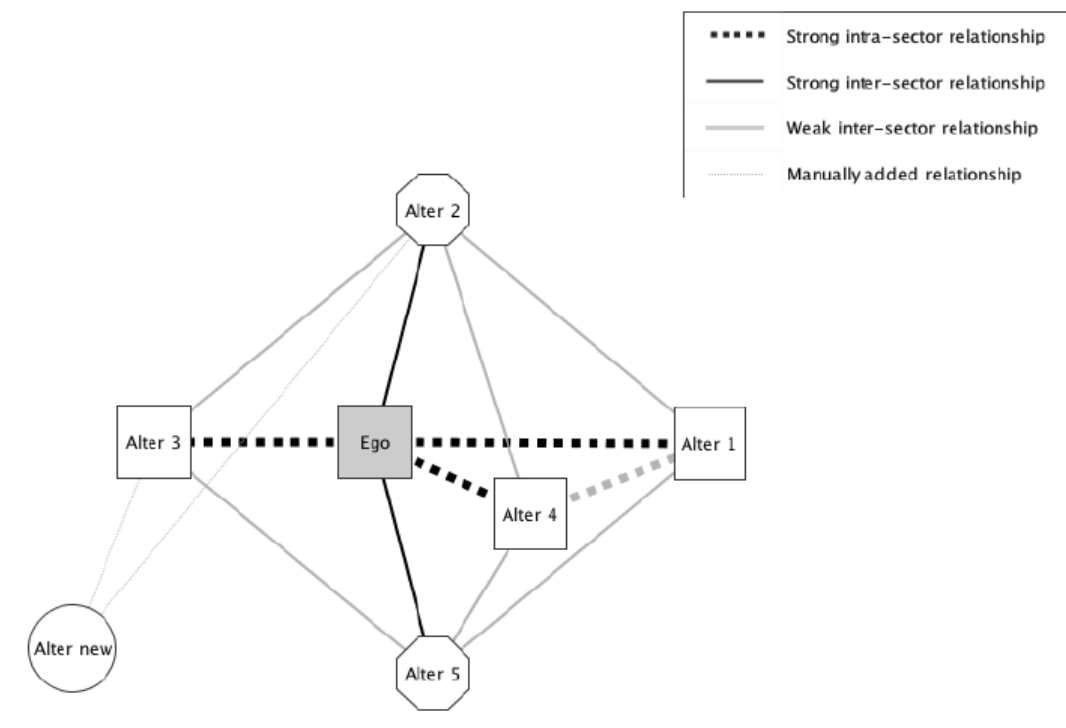
Figure 2. Example of a manual graph verification.